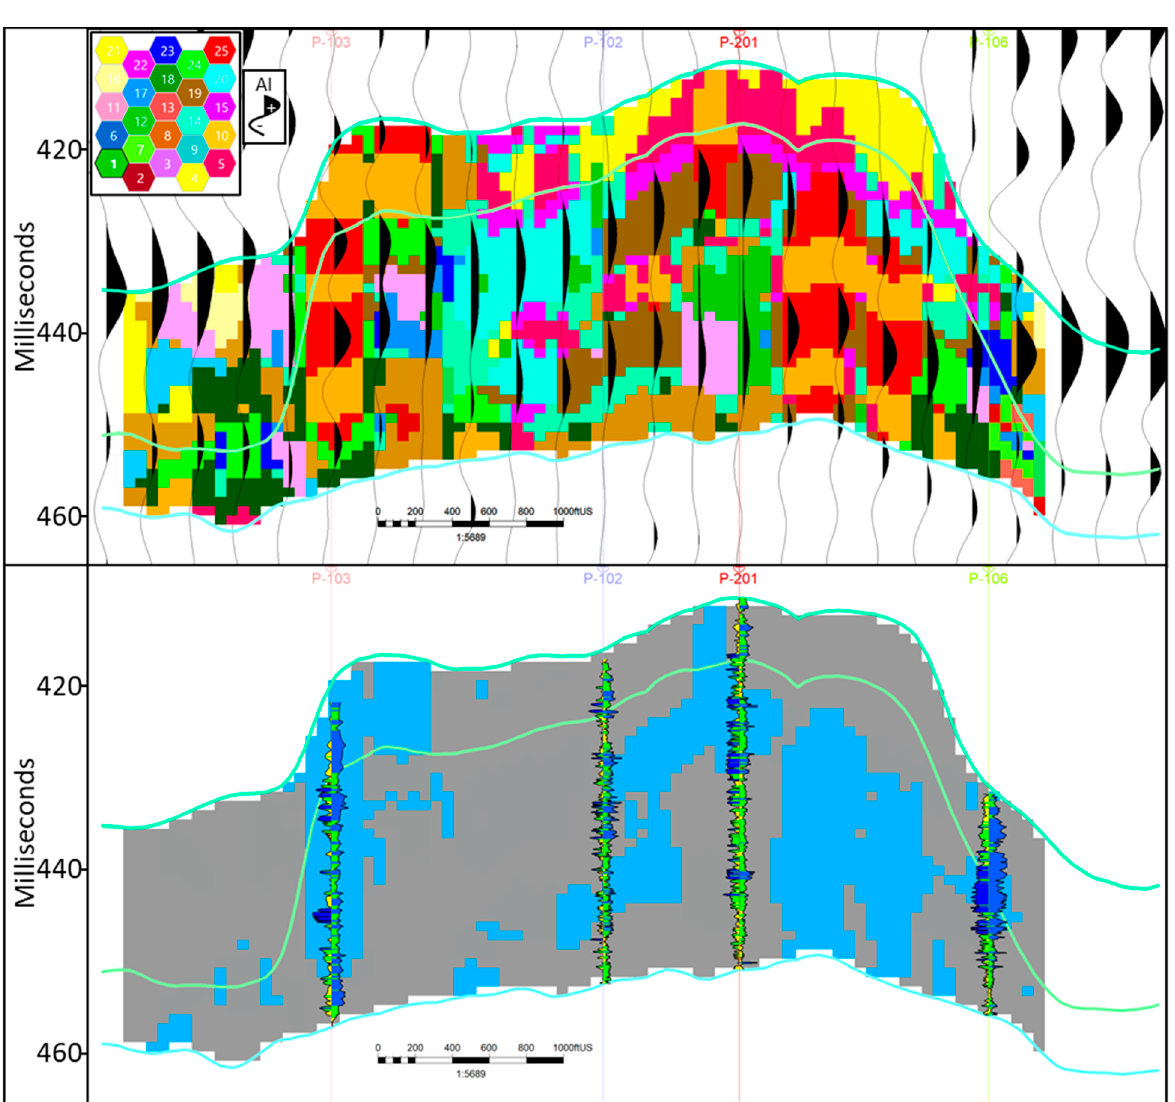
Figure 7. The top image shows the frequency SOM result with a random color bar with the A-1 Carbonate horizon, the Brown horizon, the Gray horizon, and the amplitude seismic wiggle traces overlain. The SOM results output the data into voxel sizes that were 55 by 55 feet laterally and 1 ms vertically. The bottom image shows the same SOM with a different color scale where the four neurons of interest are blue, while the rest are grey. The permeability (left) and porosity (right) logs are also now displayed. The permeability logs have a logarithmic scale from 1–1000 mD. The porosity logs have a linear scale from 1–20%.